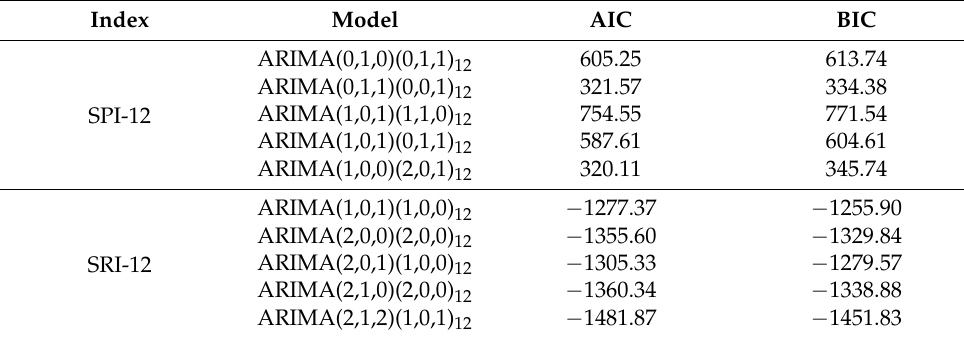
Table 2. Summary of AIC and BIC parameters of the best-fitted ARIMA models.